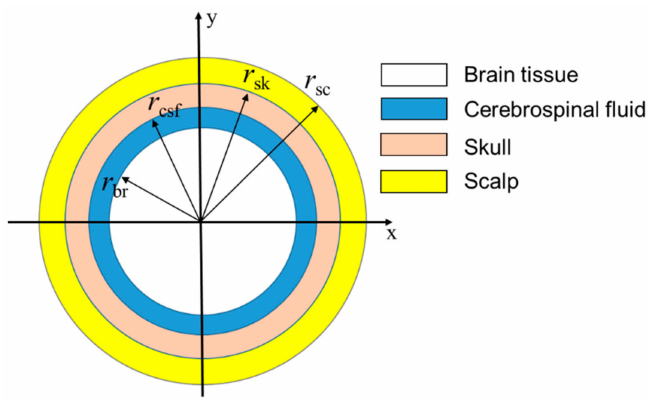
Figure 8. Simplified human brain